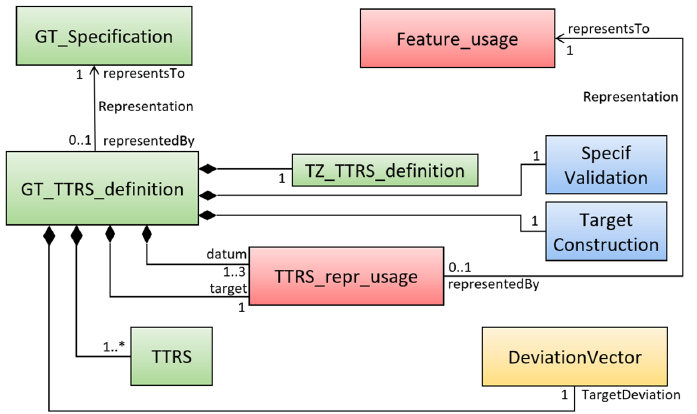
Figure 8. Abstract syntax of TTRS-based geometric tolerance representation (“*” is a “zero to many” multiplicity).